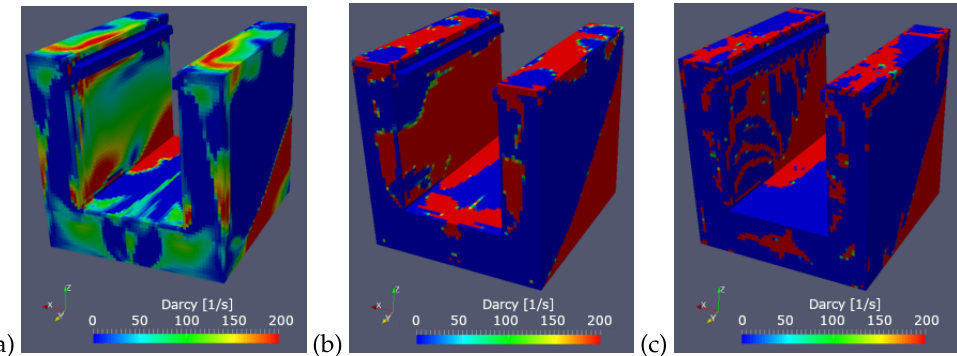
Figure 9. Distribution of the Darcy porosity α d α (back view) with steepest descent method for varying step size λ : too small ( a ), appropriate ( b ), too big ( c